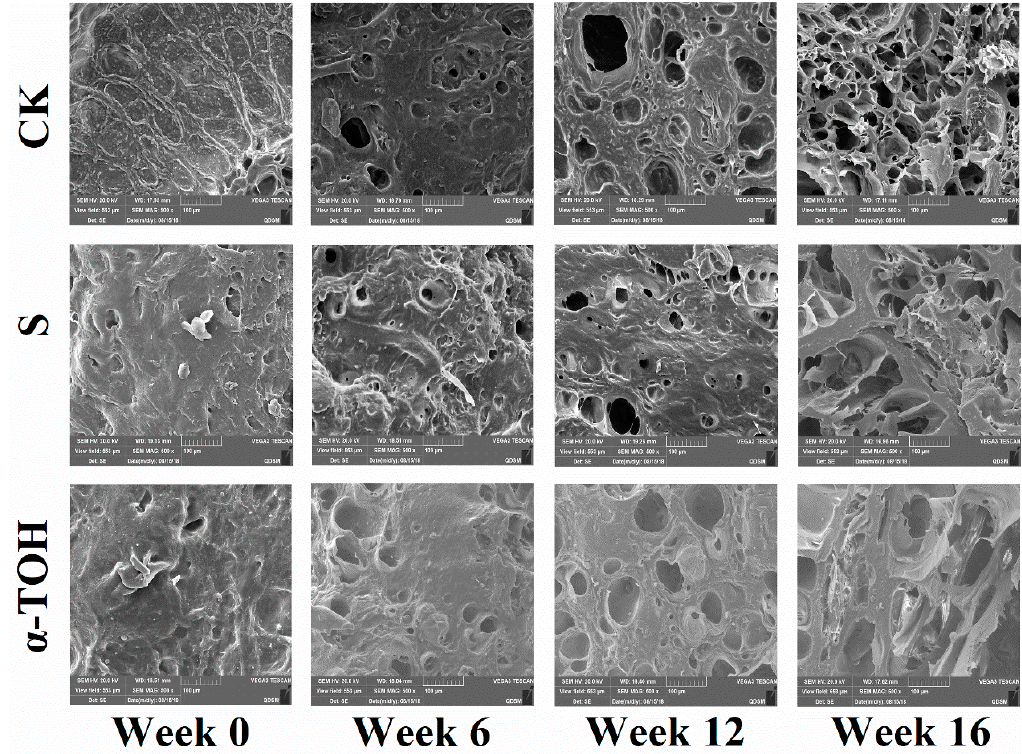
Figure 6. Effects of α -TOH on the scanning electron microscopy (SEM) images (500 × ) of sturgeon surimi during 16-week frozen storage at − 18 °C.